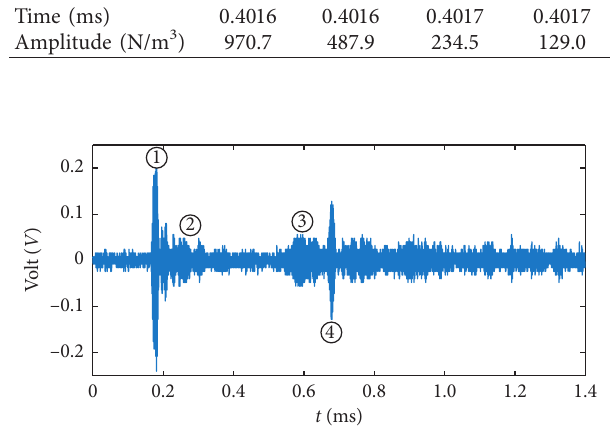
Figure 8: Oscilloscope signal on